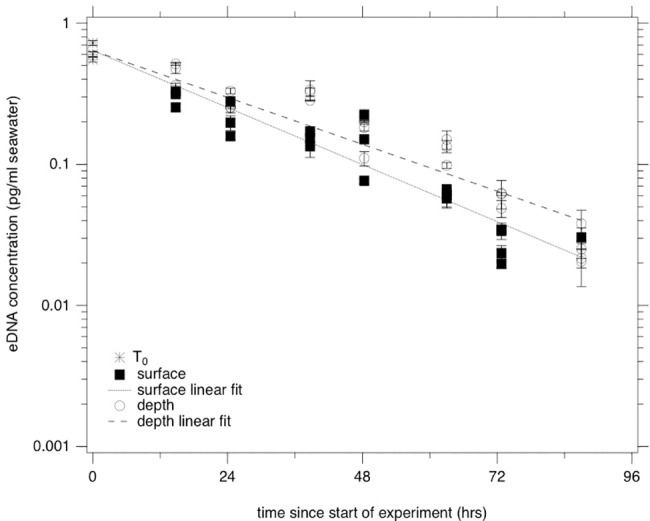
S. japonicus eDNA concentration (pg/ml seawater) as a function of time (hours) at surface (solid squares) and depth (open circles).Error bars represent standard deviation of triplicate qPCR reactions; triplicate samples shown as separate symbols at each time point (4 replicates for T6 surface and T7 depth, 1 replicate for T7 surface). Some error bars are small and hidden by overlapping symbols.